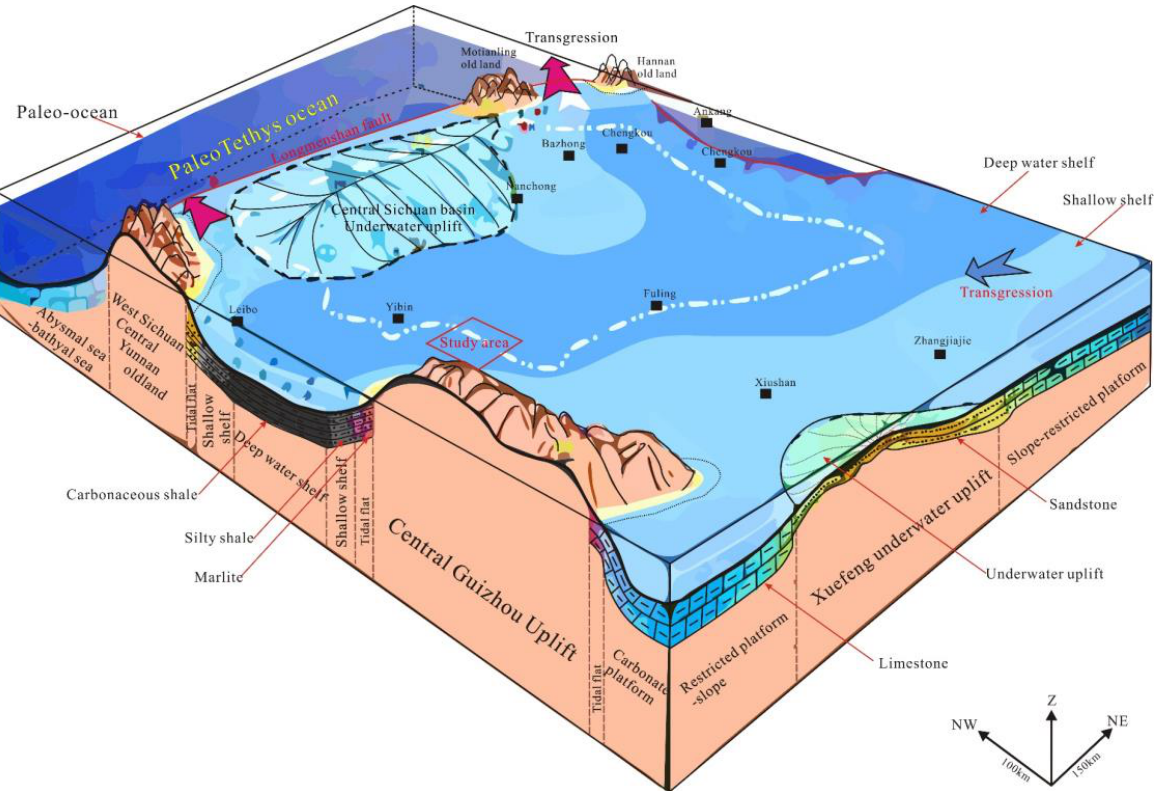
Figure 2. Depositional facies pattern of O 3 w-S 1 l, Shangluo block (after [57]).